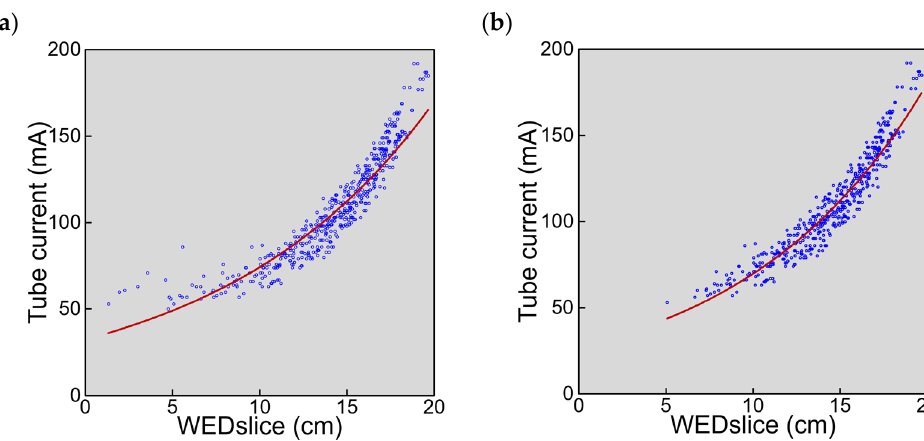
Figure 3. The relationships between tube current and WEDslice in 20 examinations. ( a ) Plots of data from all slices (y = 32.45e 0.0828x , R 2 = 0.878). ( b ) Plots excluding the most cranial slice of each image set (y = 26.98e 0.0949x , R 2 = 0.917). The red lines represent exponential regression curves.